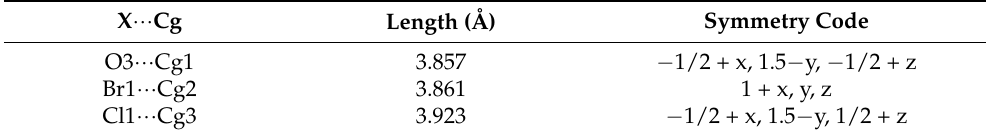
Table 4. Geometric parameters of the interactions involving π systems in